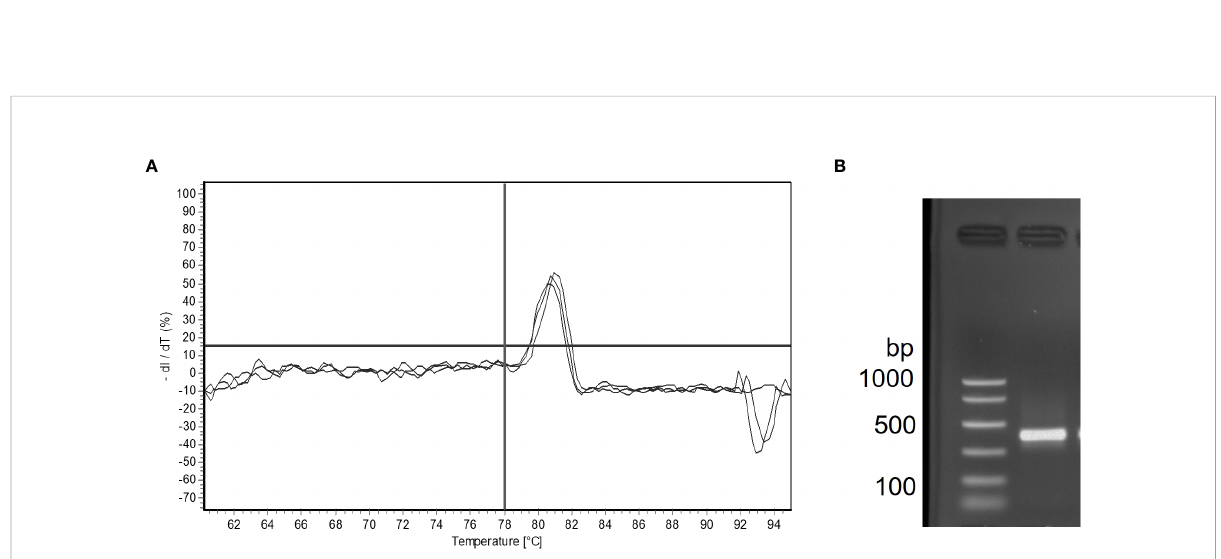
FIGURE 5 Melt curve analysis showing three technical replicates with one product melting at 81°C in a M. quahogii positive bottom seawater (BSW) sample (A) . The horizontal line is oriented at 0% dl/dT and the vertical line is oriented at 78°C. Gel electrophoresis analysis for the same sample showing one product at ~400 bp (B) . The nqPCR product was sequenced and was > 99% identical to M. quahogii (QPX) sequences in